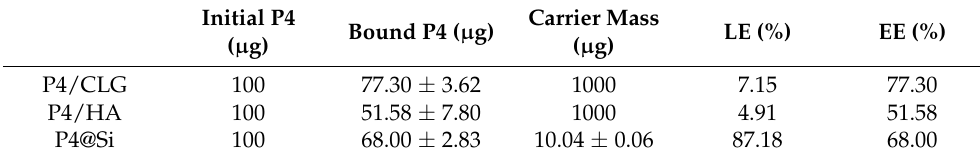
Table 2. Comparison of LE% and EE%.